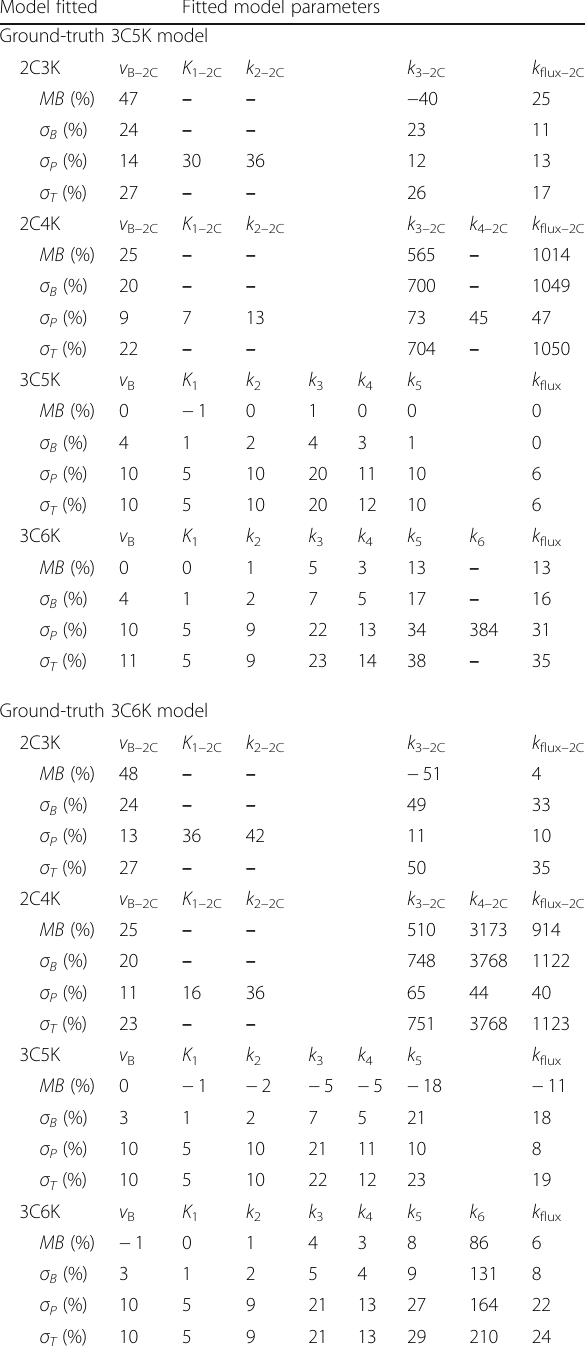
Table 3 Estimates of the accuracy and precision of parameter values obtained from fits of the 2C3K, 2C4K, 3C5K, and 3C6K models to whole tumor TACs simulated by adding whole tumor-level noise to the ground-truth, represented as 3C5K and 3C6K model fits to real TACs. Values of MB , σ B , σ P , and σ T are shown for fitted parameters as percentages of the mean values of directly related ground-truth parameters in the 3C5K or 3C6K models. When no directly related parameter exists, σ P is listed alone as a percentage of the mean fitted parameter